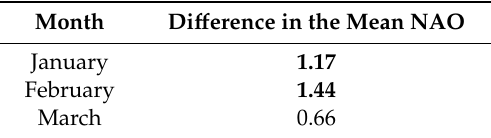
Table 10. Assessment of the mean NAO changes based on the divided trends (1951–2016 period, all months). The bold values in the second column indicate statistically significant di ff erences in the mean NAO according to the two-sample Student’s t-test. Month Di ff erence in the Mean NAO January 1.17 February 1.44 March